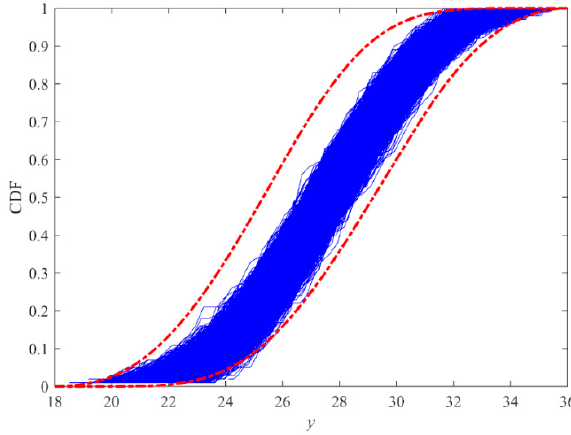
Figure 9. Cumulative probability density function of response y.